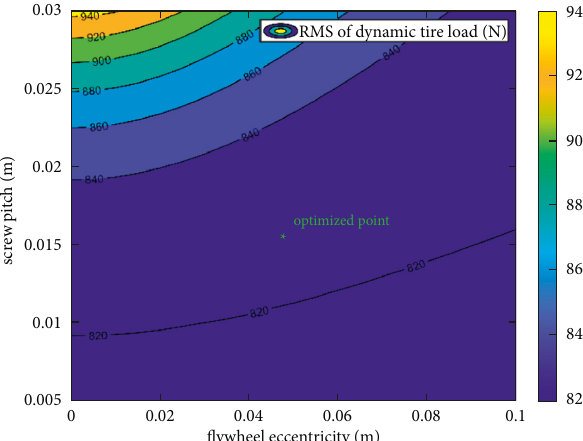
Figure 10: The change of inertance subject to the change of fly- wheel and screw